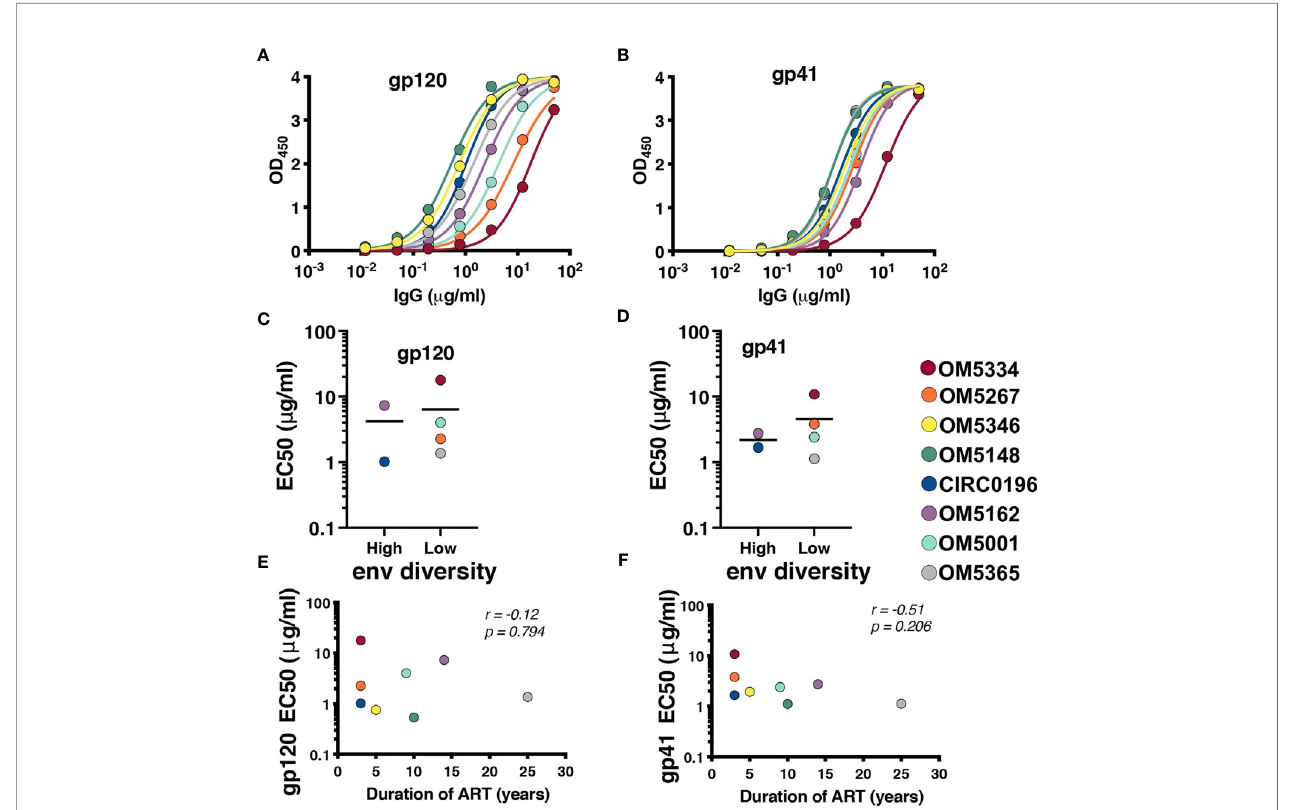
FIGURE 3 | All participants exhibit detectable anti-HIV antibodies. IgG binding for each person was assessed by indirect ELISA against (A) YU2 gp120 and (B) DIII gp41.